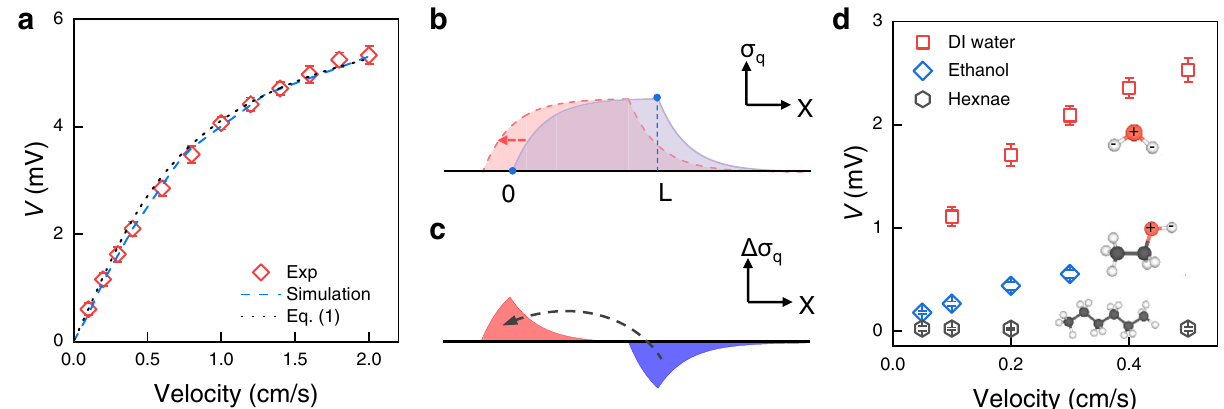
Fig. 3 Mechanism of the kinetic photovoltaic effect. a Velocity dependence of the moving-light-induced voltage. The black dotted curve is the fi t to Eq. (1), and the blue dashed curve is simulation prediction. b Blue solid curve and red dashed curve show simpli fi ed distribution of accumulated electron density in the vicinity of silicon surface at two moments for a light beam with a width of L moving to the left. The initial front and rear edge of the light beam are marked by “ 0 ” and “ L ” , respectively. c Difference of the accumulated electron density at two moments, i.e., red shaded area subtracted by blue shaded area in b , and the corresponding electron fl ow direction marked by a dark arrow. d Voltage as a function of velocity for p-type silicon in polar DI water, ethanol and nonpolar hexane, respectively. Error bars represent standard deviation. Insets show their molecular structures with labeled charge